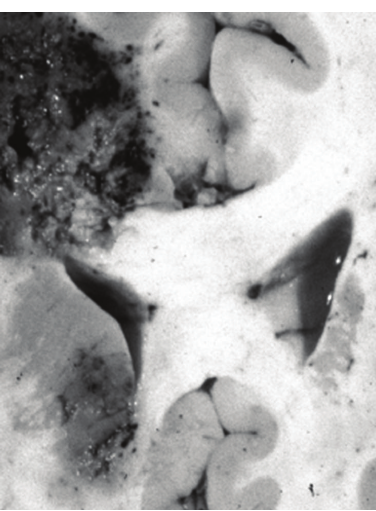
Figure 2: Autopsic brain coronal section. Right thalamus and coro- na radiata abscessed hemorrhagic infarcts.